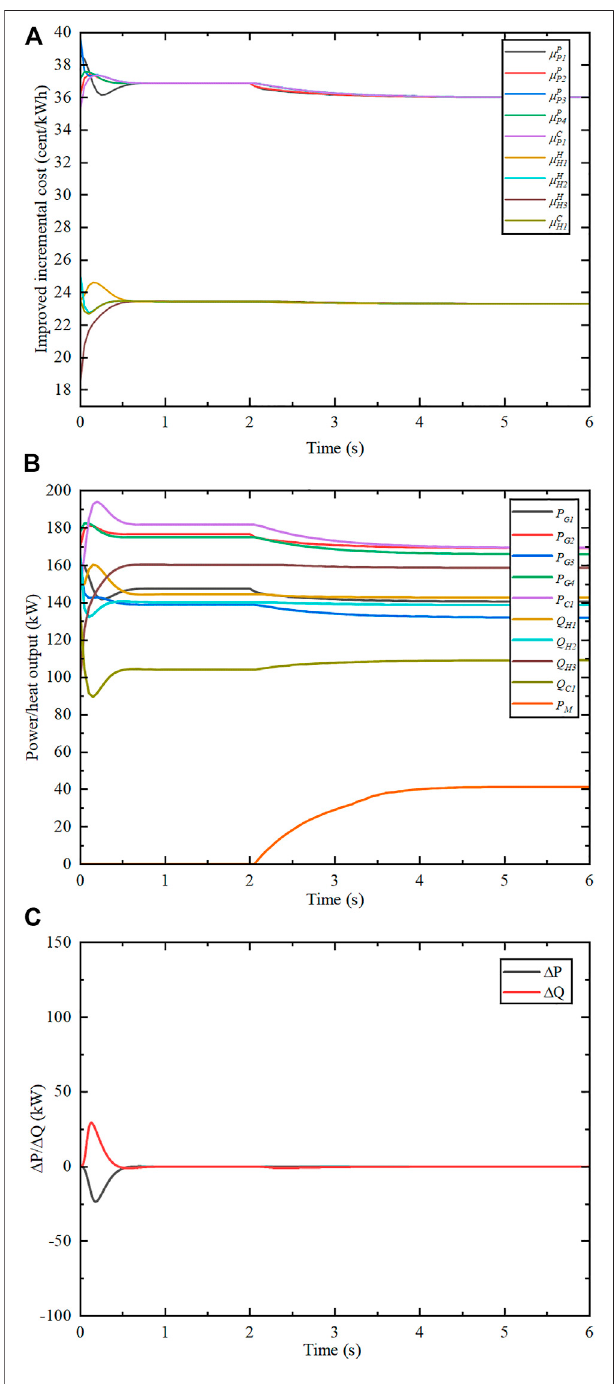
FIGURE 7 | Algorithm results when operation mode switching. (A) Improved incremental cost. (B) Power output of each unit. (C) Electrical and thermal power